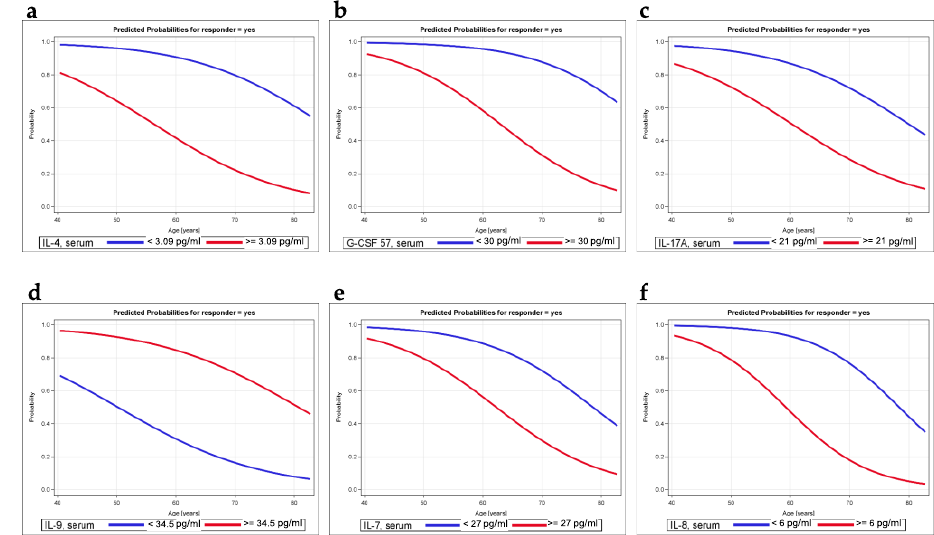
Figure 3. Predicted probability of a response obtained from age-adjusted logistic models. As an example, the age-weighted probability of being a responder based on cytokine levels is shown for the serum cytokines IL-4 ( a ), G-CSF ( b ), IL-17A ( c ), IL-9 ( d ), IL-7 ( e ), and IL-8 ( f ). The blue curves illustrate the probability of having serum cytokine levels below the optimal cutoff, and the red lines represent the probability of having serum cytokine levels above the cutoff.